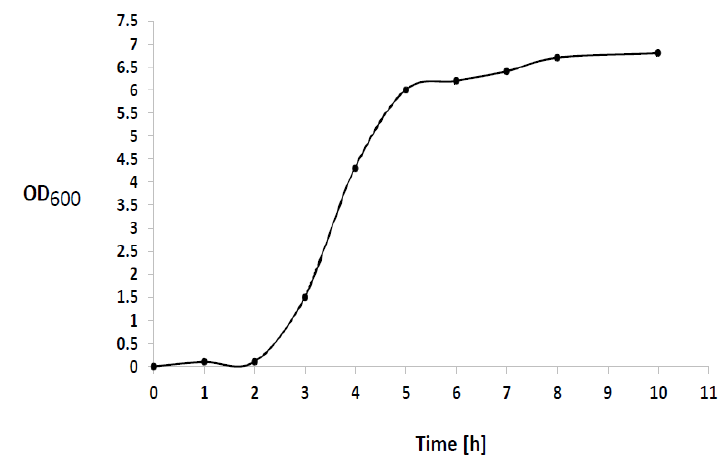
Figure 2. Growth curve of Lactobacillus rhamnosus ATCC 53103. Conditions: anaerobic flask, MRS broth, 37 °C, inoculum 7.5 × 10 7 CFU/mL, 130 rpm.